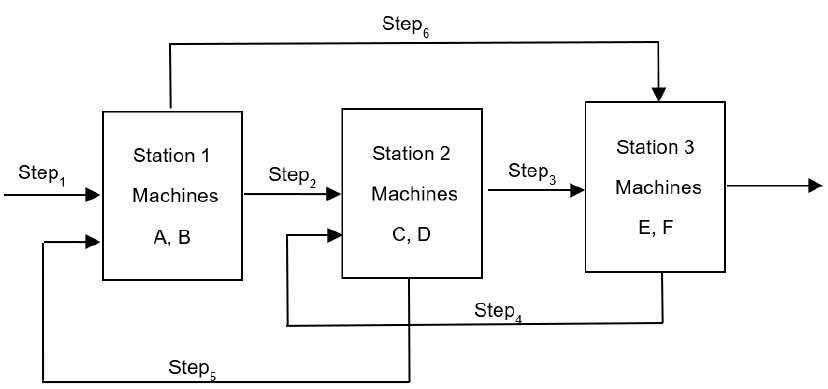
Figure 2. Illustration of the re-entrant flow shop under study.